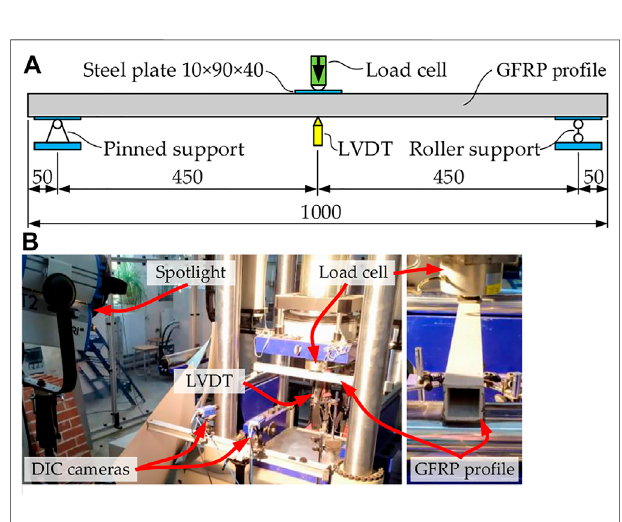
FIGURE 7 | Three-point bending test: (A) Loading scheme; (B) Test setup.